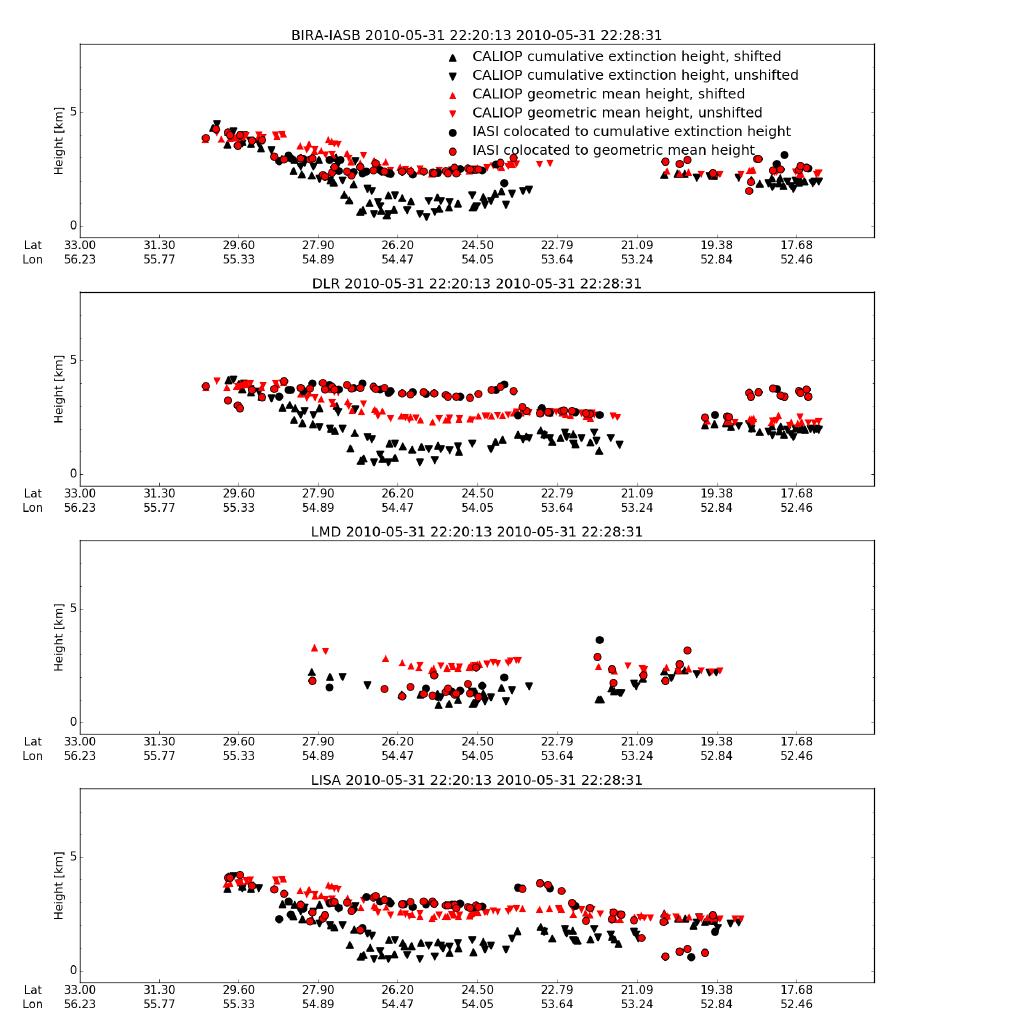
Figure 4. IASI dust-layer heights co-located to CALIOP cumulative extinction heights (black circles) and CALIOP geometric mean heights (red circles) for the same time and location as in Fig. 3. Also shown are shifted (upward triangles) and unshifted (downward triangles) CALIOP cumulative extinction and geometric mean